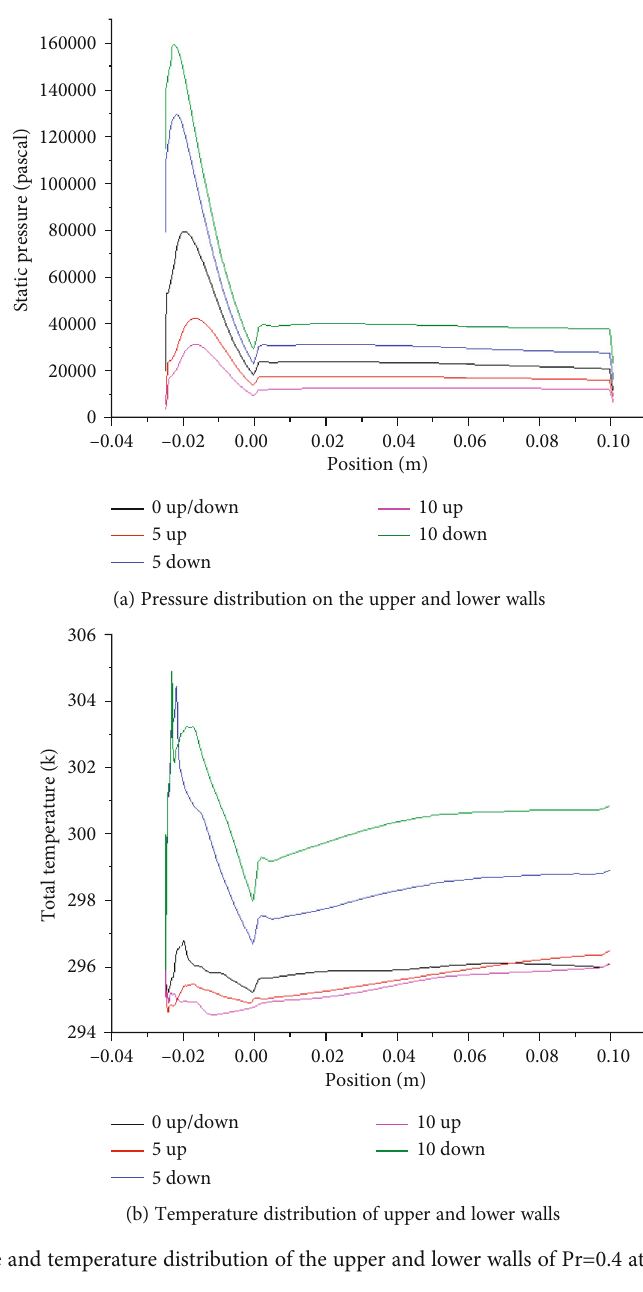
Figure 13: The pressure and temperature distribution of the upper and lower walls of Pr=0.4 at di ff erent angles of